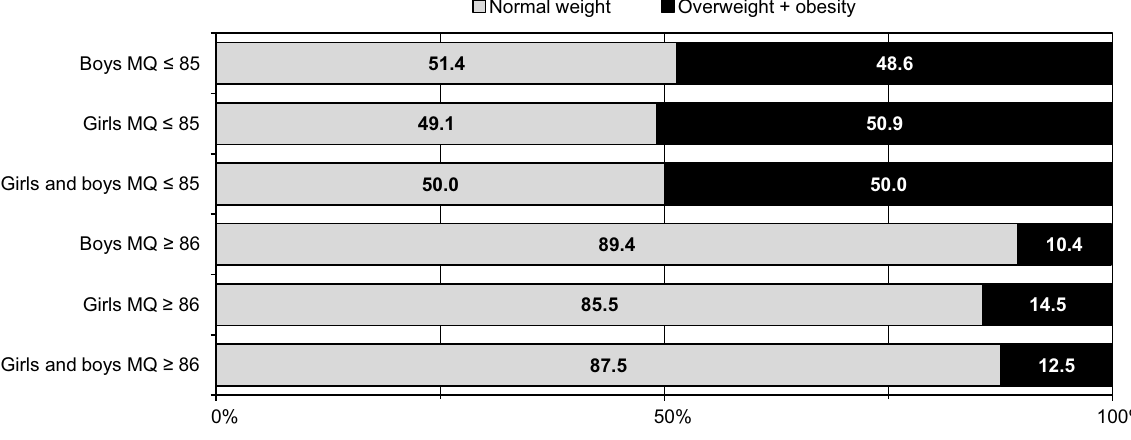
Figure 1. Distribution of body mass index in the groups divided according to motor quotient (MQ KTK).